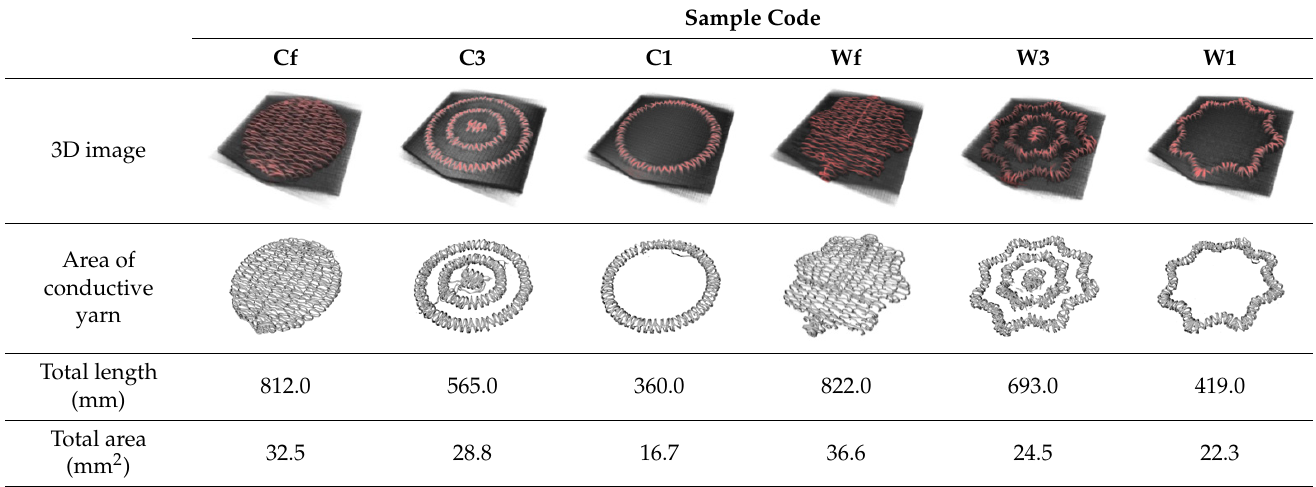
Table 2. 3D image and area of conductive yarn of embroidery-based textile electrodes. Sample Code